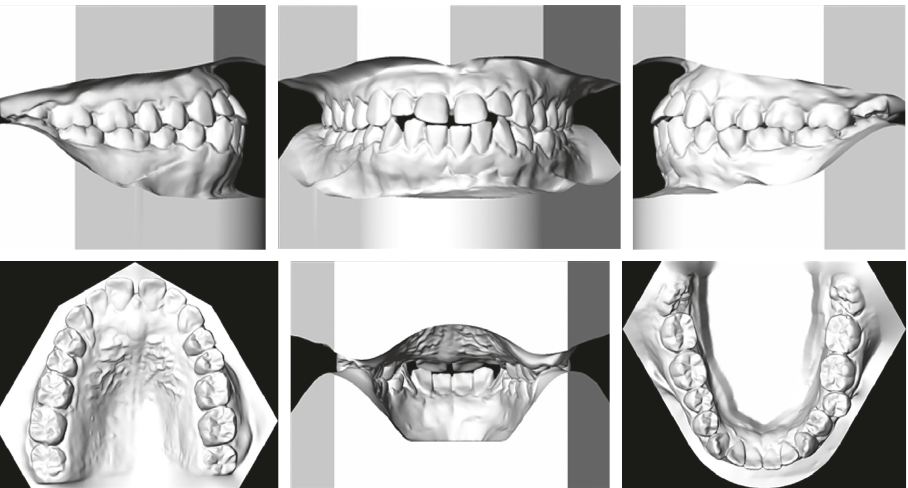
Figure 2: Pretreatment dental casts.